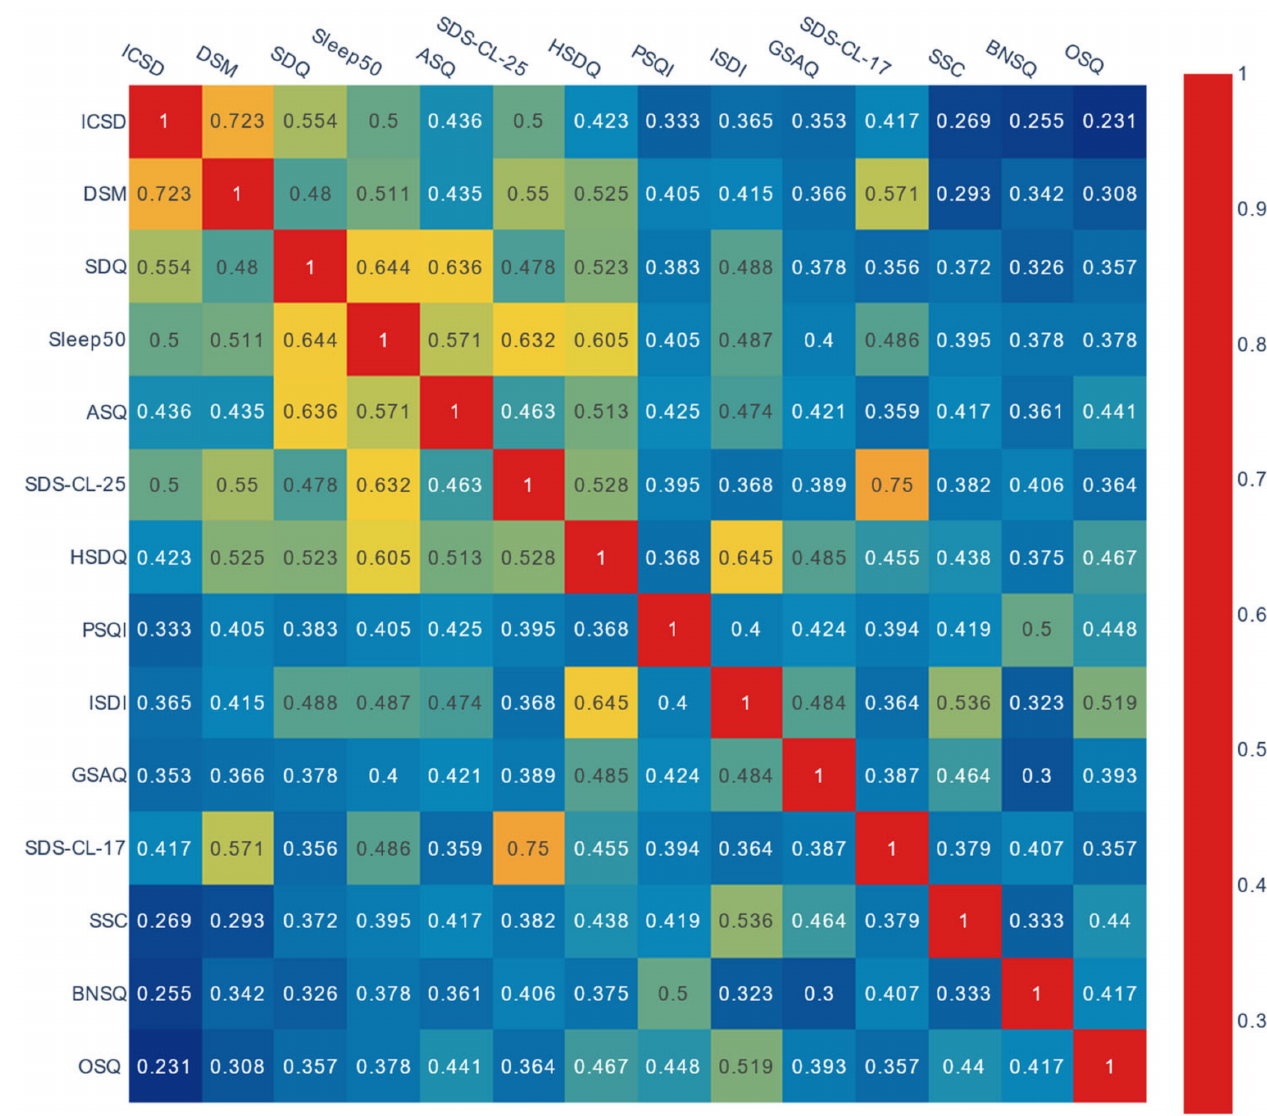
Figure 3. Jaccard Index overlap of item content of the 12 self-reported multiple sleep disorder screening questionnaires for each pair of questionnaires. ICSD: International Classification of Sleep Disorders, DSM: Diagnostic and Statistical Manual of Mental Disorders, SDQ: Sleep Disorder Ques- tionnaire, ASQ: Auckland Sleep Questionnaire, HSDQ: Holland Sleep Disorders